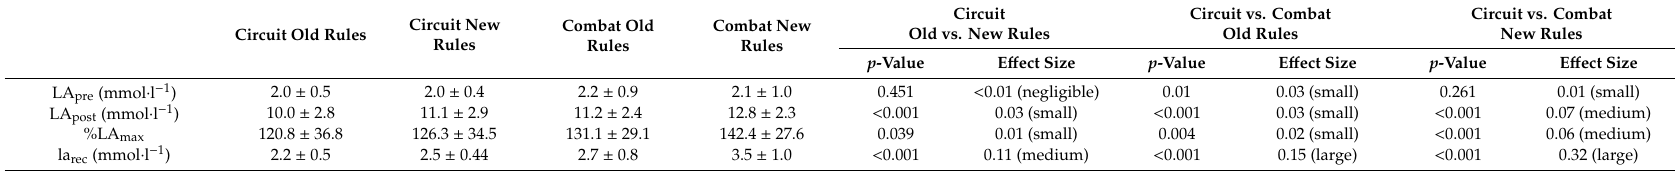
Table 5. Lactate concentration during taekwondo-specific circuit training and combat—comparison between old and new rules.